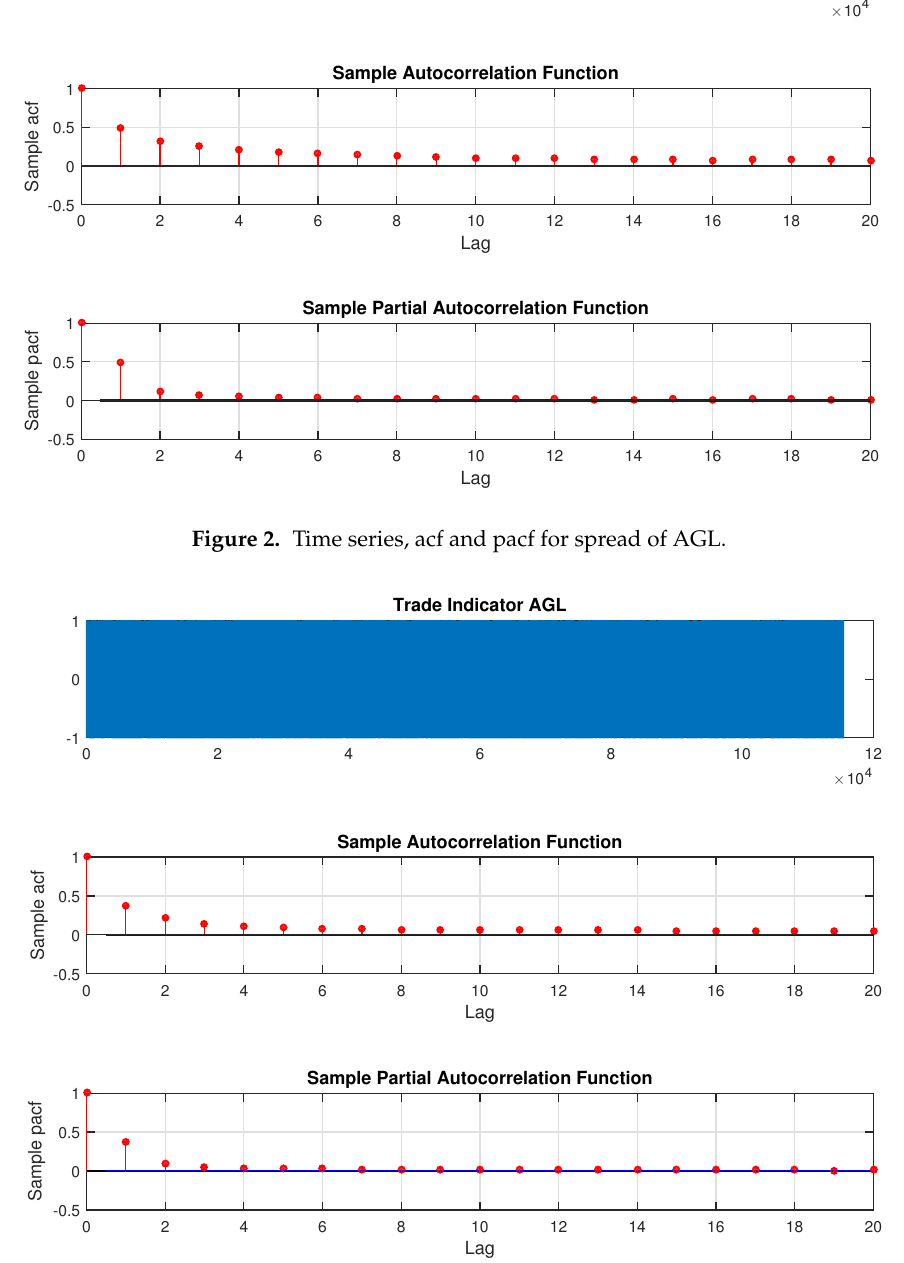
Figure 3. Time series, acf and pacf for trade indicator of